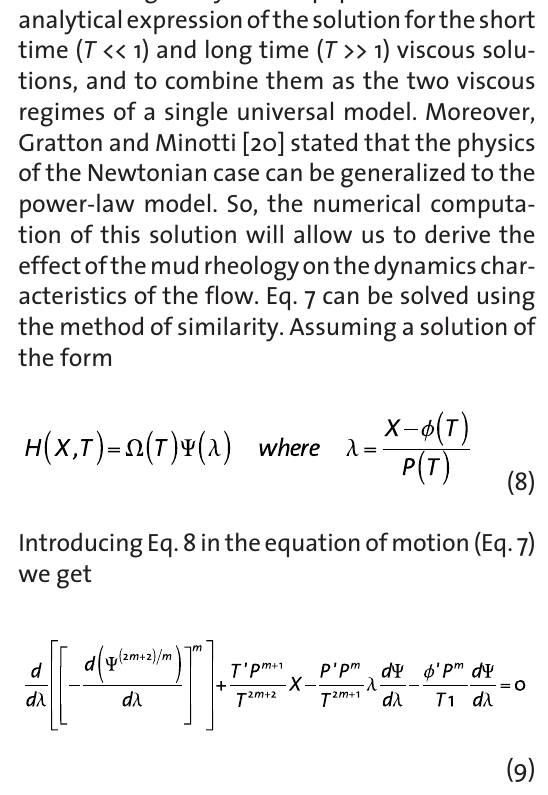
Figure 2: Time variation of free surface profile in the short time regime (a) and in the long time regime